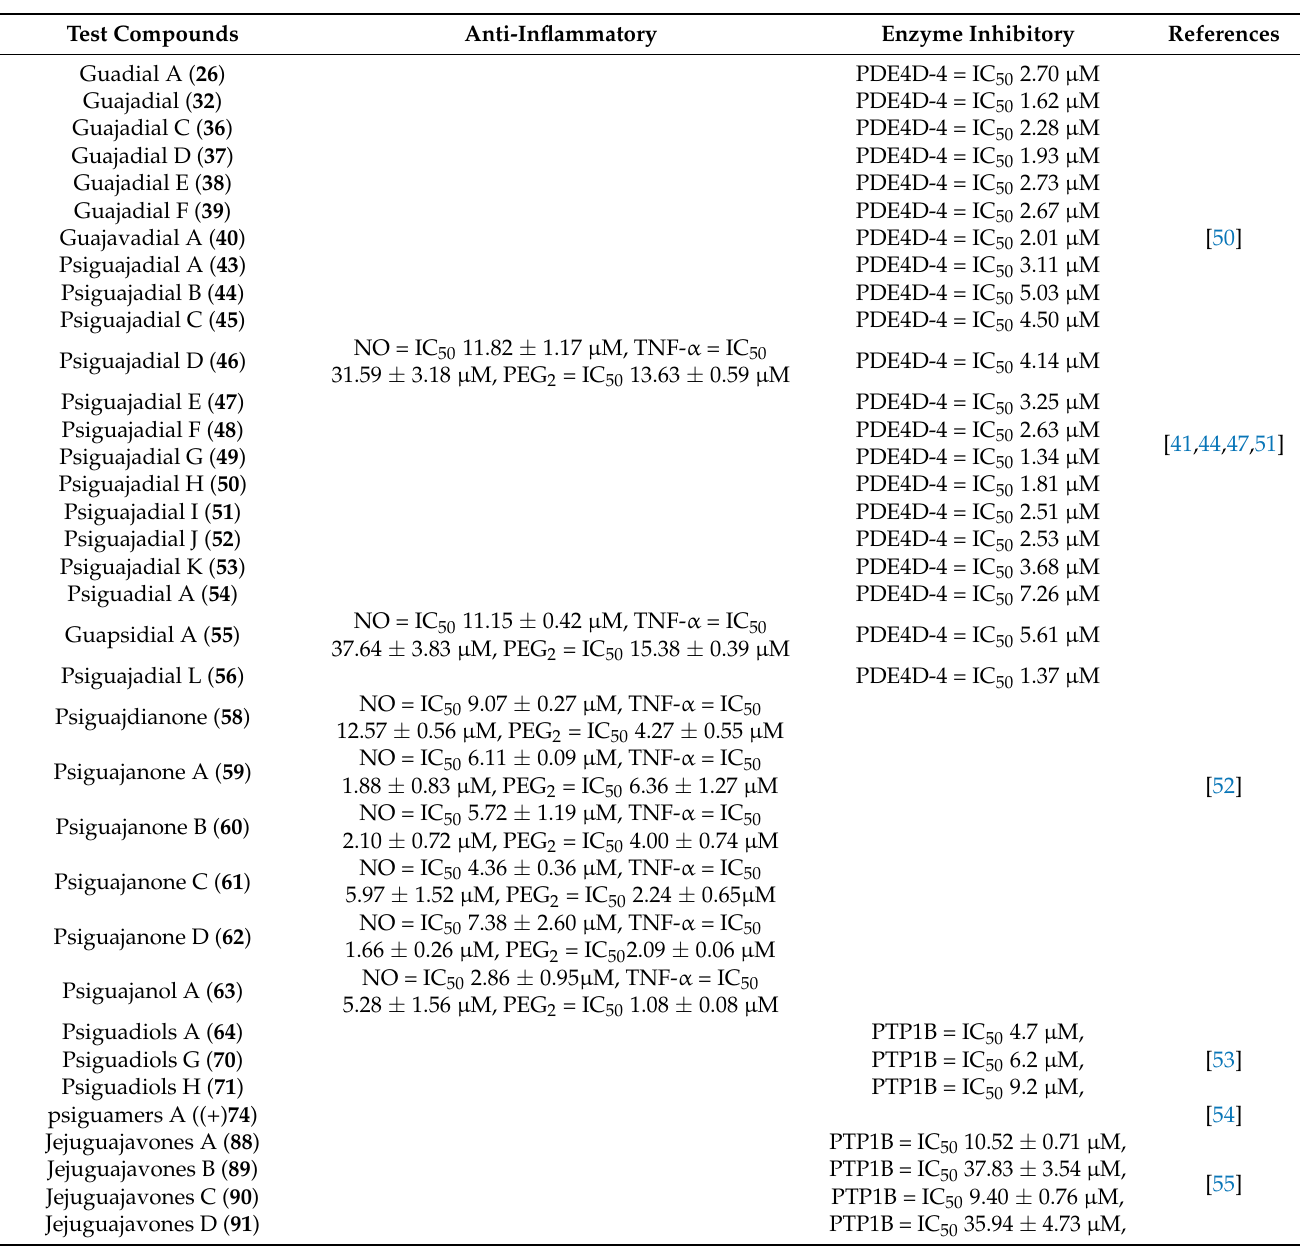
Table 6. Anti-inflammatory and Enzyme inhibitory activities of isolated compounds from P. guajava